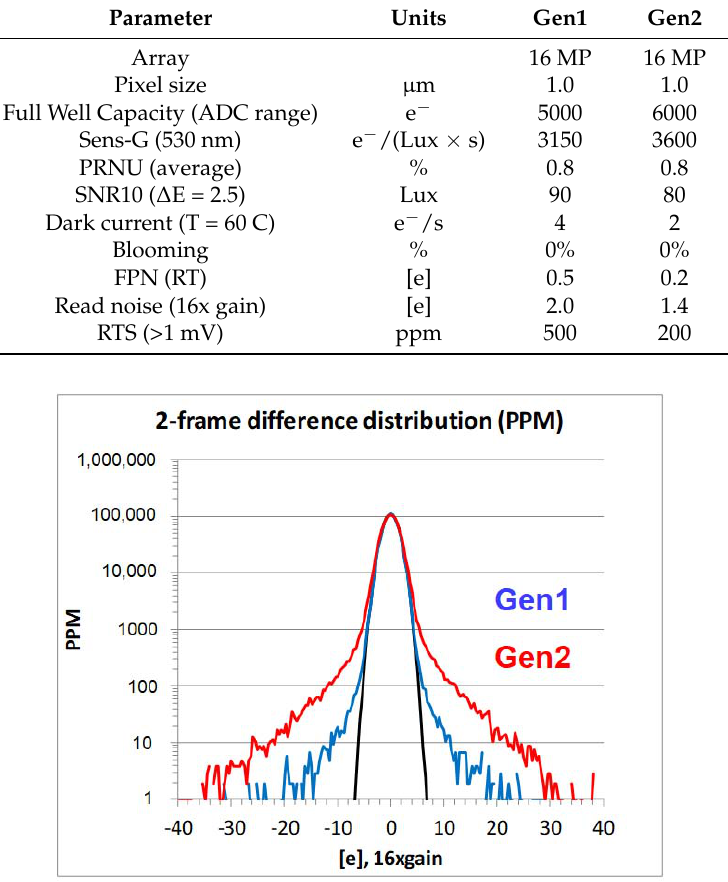
Table 1. Pixel performance comparing Gen1 and Gen2 BSI-stacking technologies (1 µm, 16 MP products).